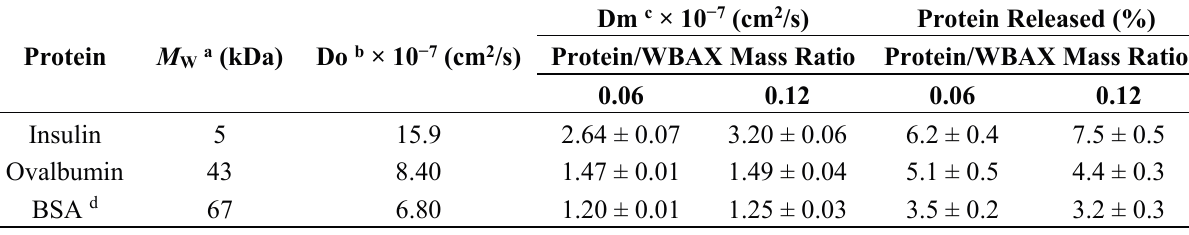
Table 3. Apparent diffusion coefficients and release of proteins with different molecular weight in wheat bran arabinoxylan (WBAX) gels at different protein/polysaccharide mass